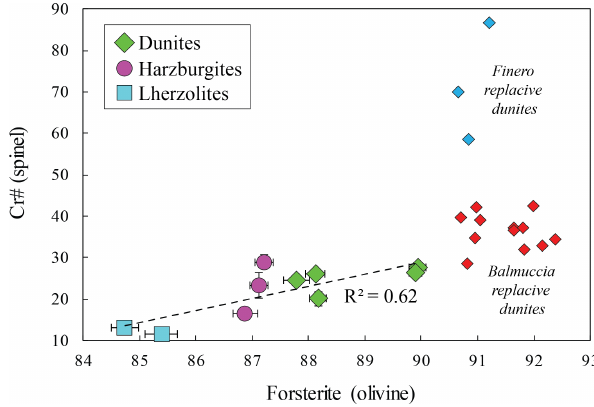
Figure 9. Plot of Cr# [100 × Cr /( Cr + Al ) , mol%] of spinel ver- sus forsterite proportion of coexisting olivine (mol%) for the Rocca d’Argimonia peridotites. Data are averaged per sample; error bars represent the standard deviation of the mean value (2 σ ). The com- positions of spinel–olivine pairs from mantle replacive dunites of the Balmuccia and Finero mantle sequences (Mazzucchelli et al., 2009; Bussolesi et al., 2019; Corvò et al., 2020) are reported for comparative